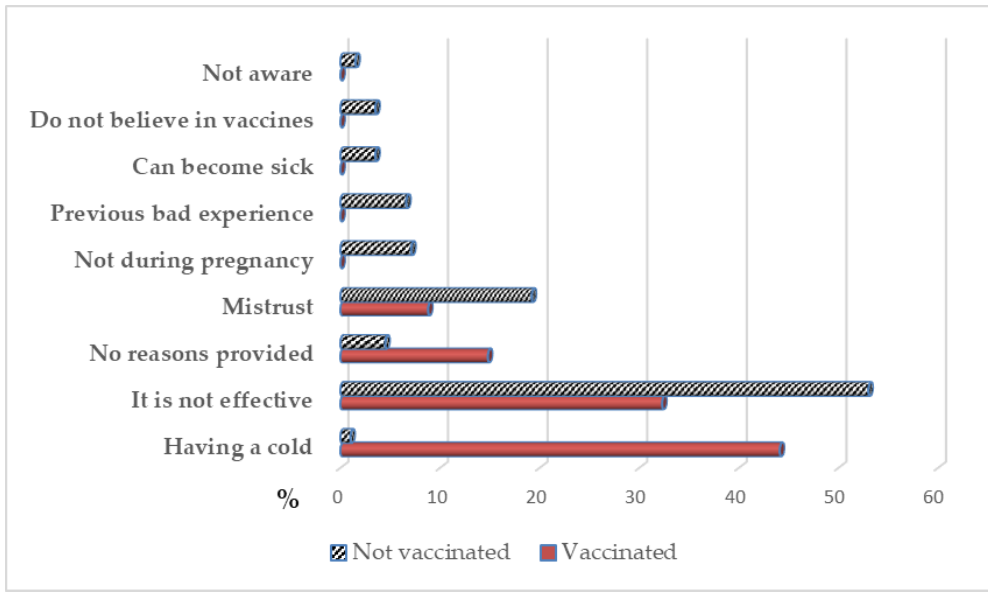
Figure 1. Reasons for rejecting vaccine in the next pregnancy.